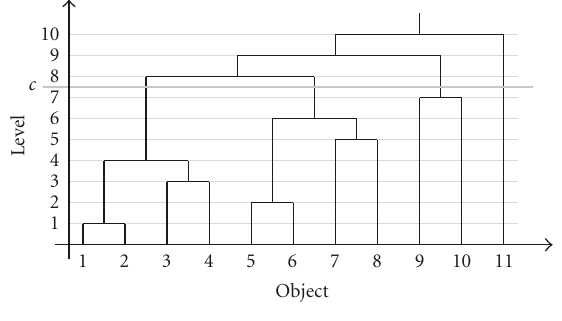
Figure 2: Linking the closest clusters.